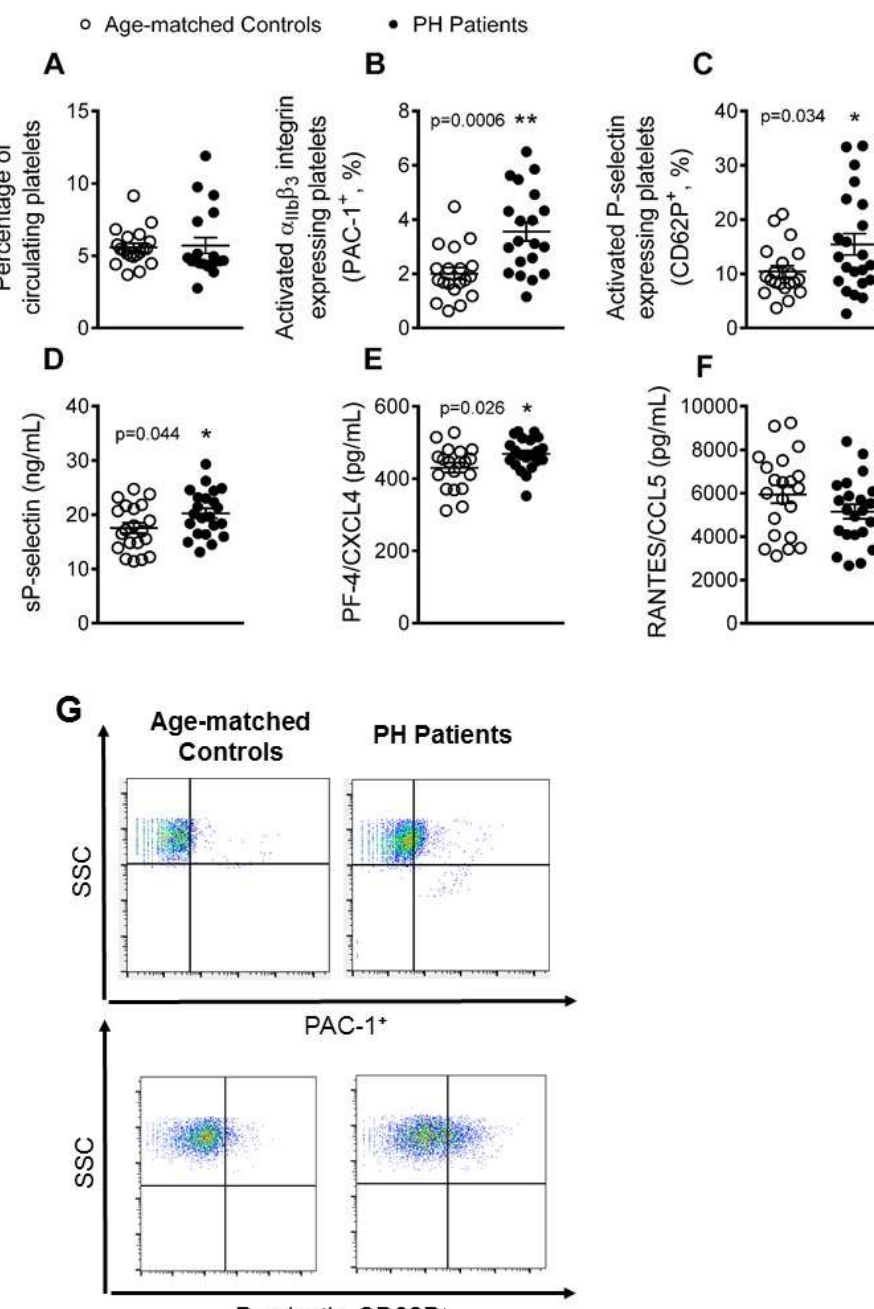
Figure 1. Platelet activation and related soluble markers are elevated in patients with PH. Flow cytometry analysis of platelets stained with conjugated antibodies against CD41 ( A ), CD41 and PAC-1 ( B and G ), and CD41 and P-selectin ( C and G ). Results are expressed as percentage of positive cells. Soluble P-selectin (sP-selectin, D ), PF-4/CXCL4 ( E ) and RANTES/CCL5 ( F ) plasma levels (ng or pg/mL) were measured by ELISA. ( n = 21 control subjects and n = 22 PH patients). Values are expressed as mean ± SEM. SSC: Side Scatter. * p < 0.05 or ** p < 0.01 relative to values in the control group.